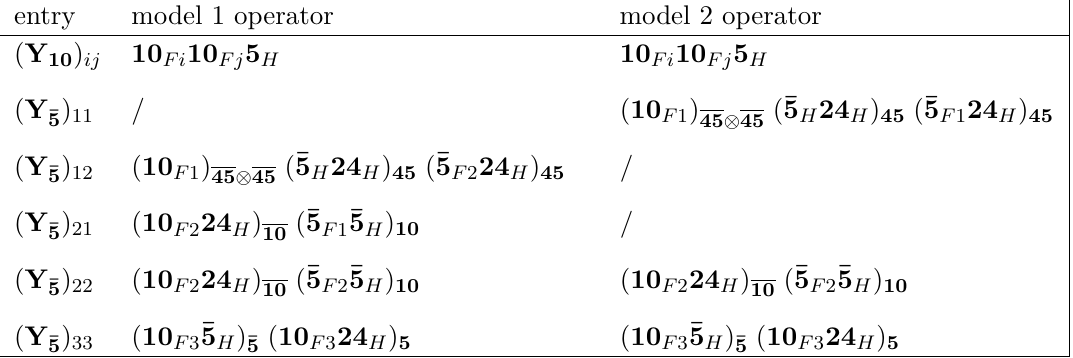
Table 1 . Table of operators used in each Yukawa entry for models 1 and